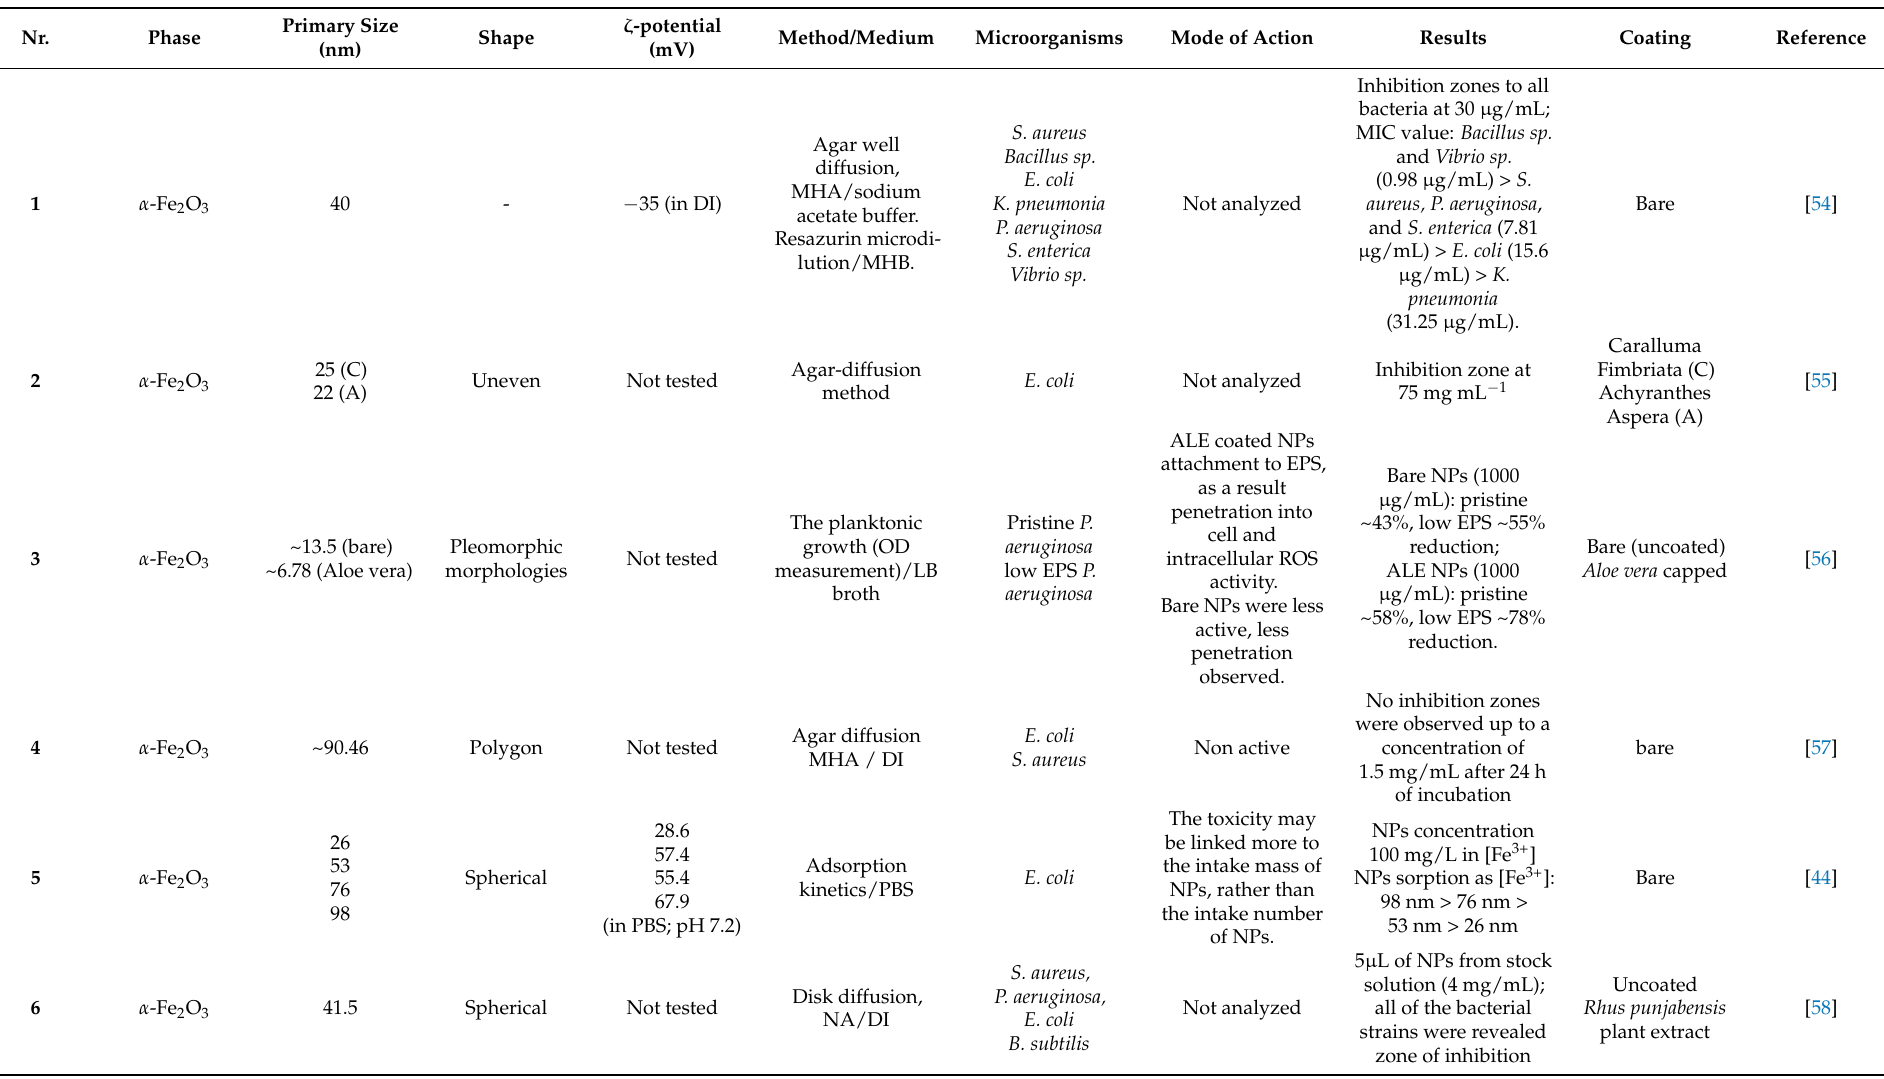
Table 1. Antimicrobial properties of hematite: literature